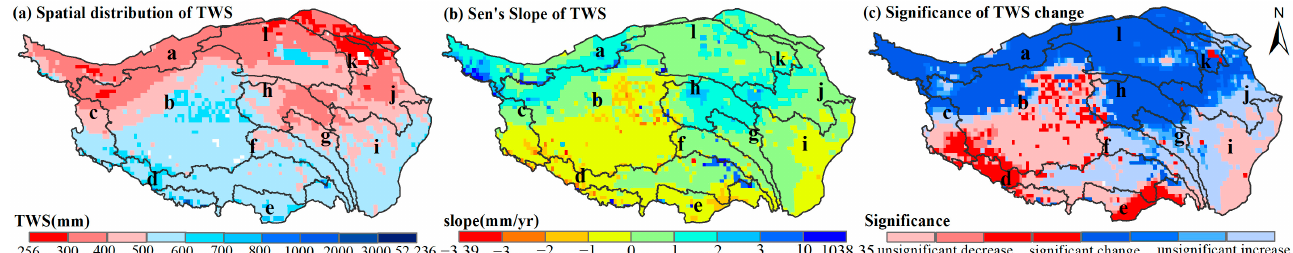
Figure 3. Spatial distribution and its changing trend of terrestrial water storage over the Tibetan Plateau during the period 1981–2015.